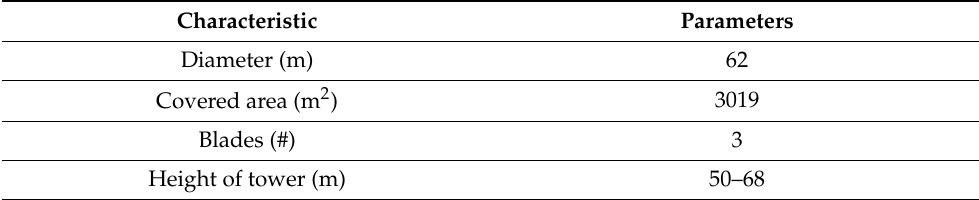
Table 4. Characteristics of the wind